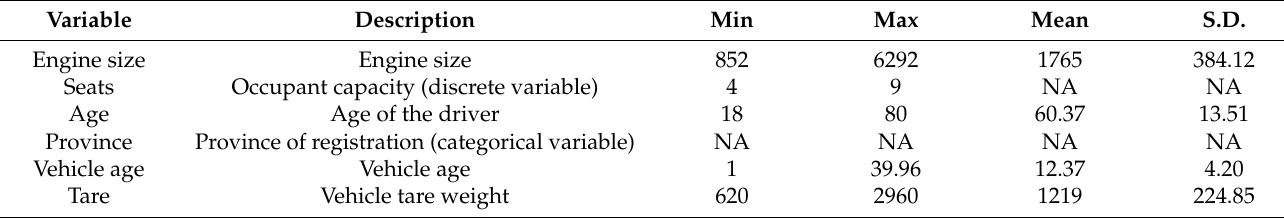
Table 3. Predictive variables of kilometers per